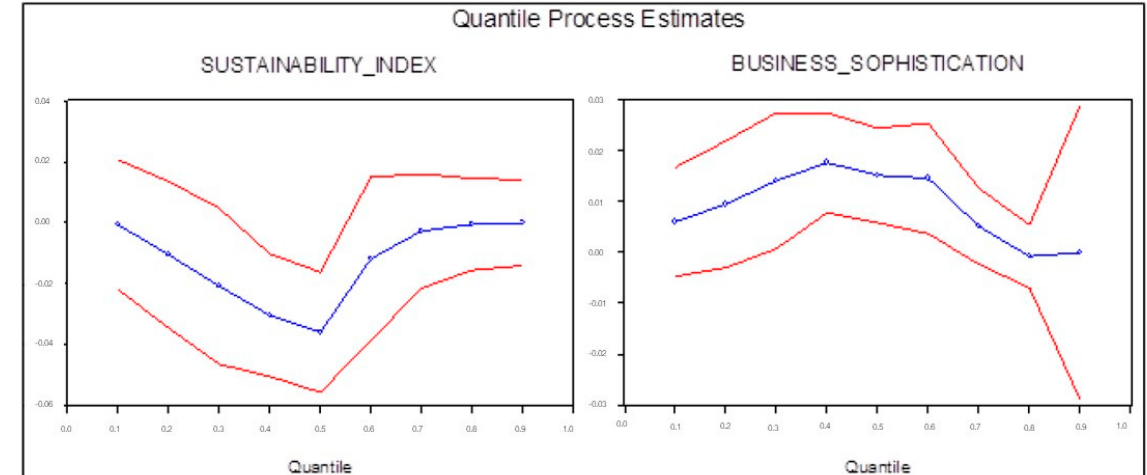
Figure 8. Regression coefficient estimates of the different quantiles. Source: authors’